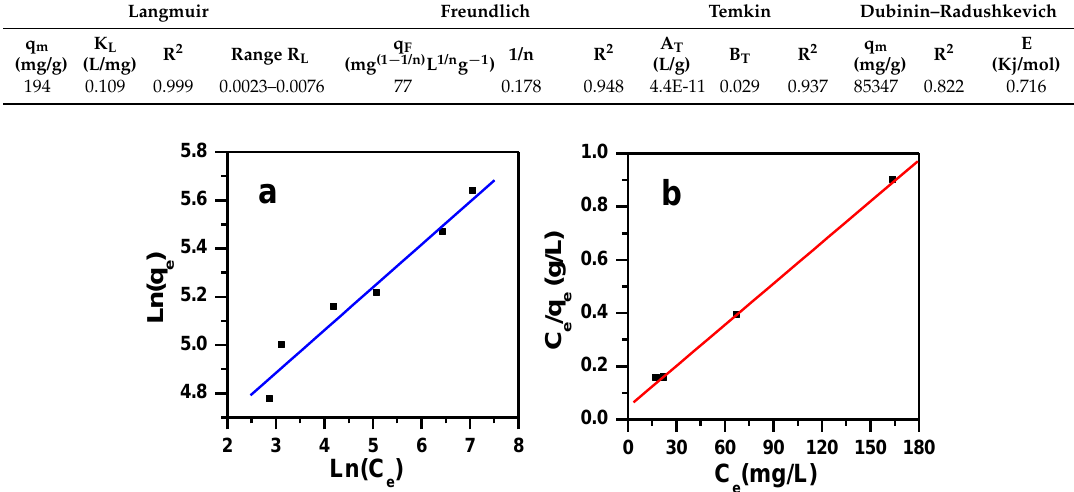
Figure 11. Freundlich ( a ) and Langmuir ( b ) isotherms plot for the effect of initial dye concentration on removal of MB using MNS-4.